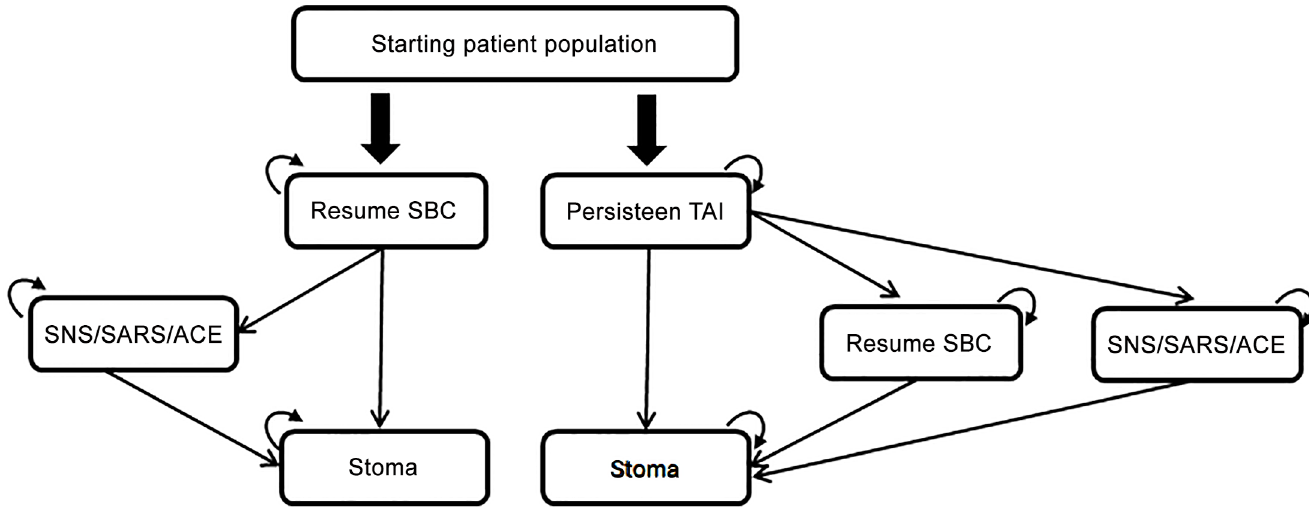
Fig 1. Data and Markov model overview. The boxes represent the health states that a neurogenic patient can transition between after having failed standard bowel care (SBC) before and after 2007. SBC alone. After having failed SBC > 6 months, a patient can either a) Resume SBC, b) Progress to SNS/SARS/ACE or d) Progress to stoma (absorbing state). TAI in combination with SBC. After having failed SBC > 6 months, a patient can either a) Initiate Peristeen TAI, b) Resume SBC, c) Progress to SNS/SARS/ACE or d) Progress to stoma. The model assumes that patients do not transition directly from SBC/TAI to stoma . Transition probabilities have been obtained for each 6-month model cycle using GoalSeek in Excel